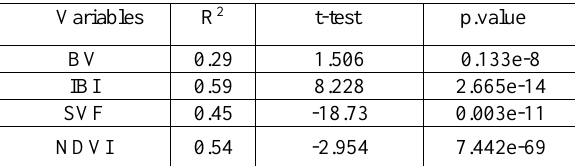
Table 2. Statistical results of the parameters used in this